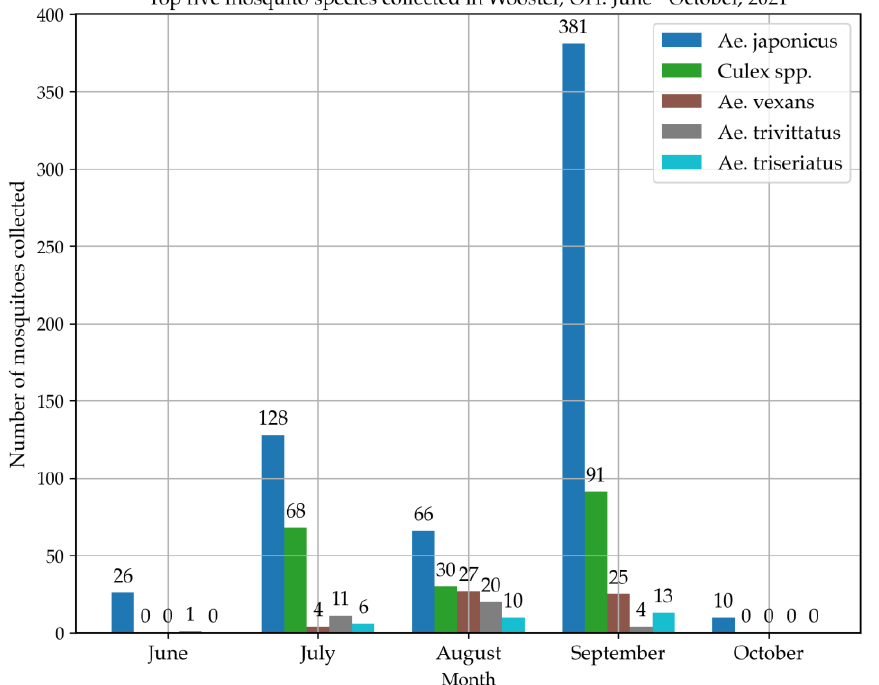
Figure 4. Abundance of top five mosquito species collected in Wooster 2021. The total number of mosquitoes collected each month, regardless of the location, was included in this figure. The combined counts for all trap types were used to generate this figure. Table 1. The abundance and diversity of mosquitoes collected in Wooster. Combined counts for all trap types were used to generate this table.